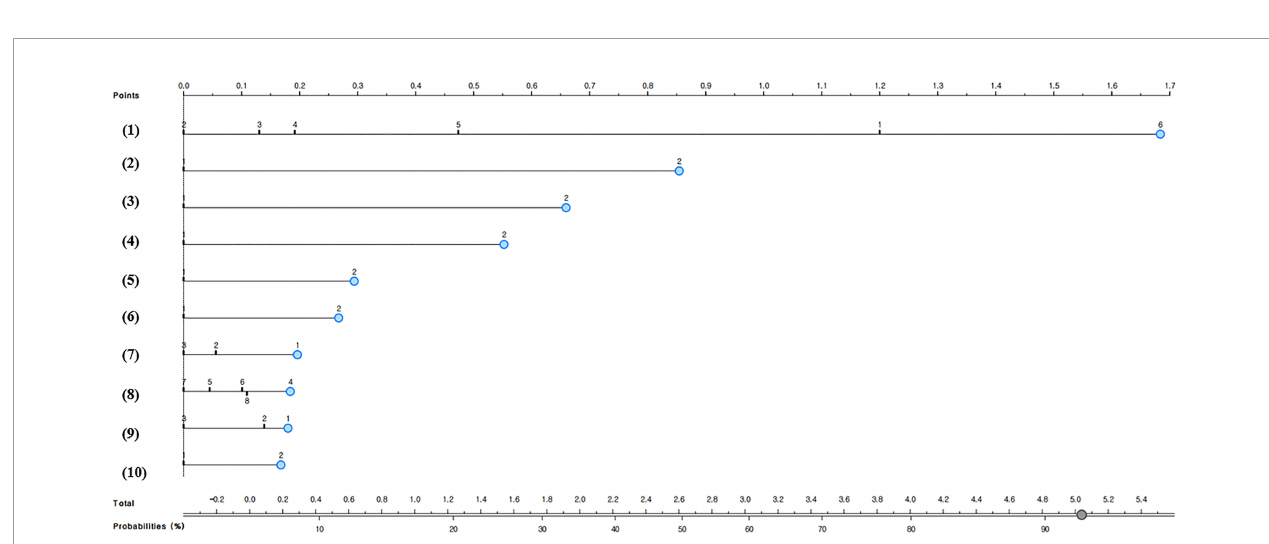
FIGURE 1 | Nomogram for predicting the non-utilization of fundus examination in South Korean diabetic patients; (1) Number of glycated hemoglobin tests in the past year: 1 = don ’ t know what glycated hemoglobin is, 2 = 4 times or more, 3 = 3 times, 4 = 2 times, 5 = 1 time, or 6 = not measured, (2) Insulin treatment: 1=Yes or 2=No, (3) Oral diabetes medication: 1=Yes or 2=No, (4) Completion of diabetes management education: 1=Yes or 2=No, (5) Age: 4= ≤ 49 years old, 5 = 50-59 years old, 6 = 60-69 years old, 7 = 70-79 years old, or 8 = 80 years old or older, (6) Residential area: 1=Urban or 2=Rural, (7) Subjective health: 1 = good, 2 = moderate, or 3 = poor, (8) Education level: 1 = elementary school graduation or below, 2 = middle school graduation, 3 = high school graduation, or 4 = college graduation or above, (9) Diabetes non-drug treatment: 1 = Yes or 2 = No, and (10) Smoking: 0 = non-smoker, 1 = ex-smoker, or 2 = current smoker.